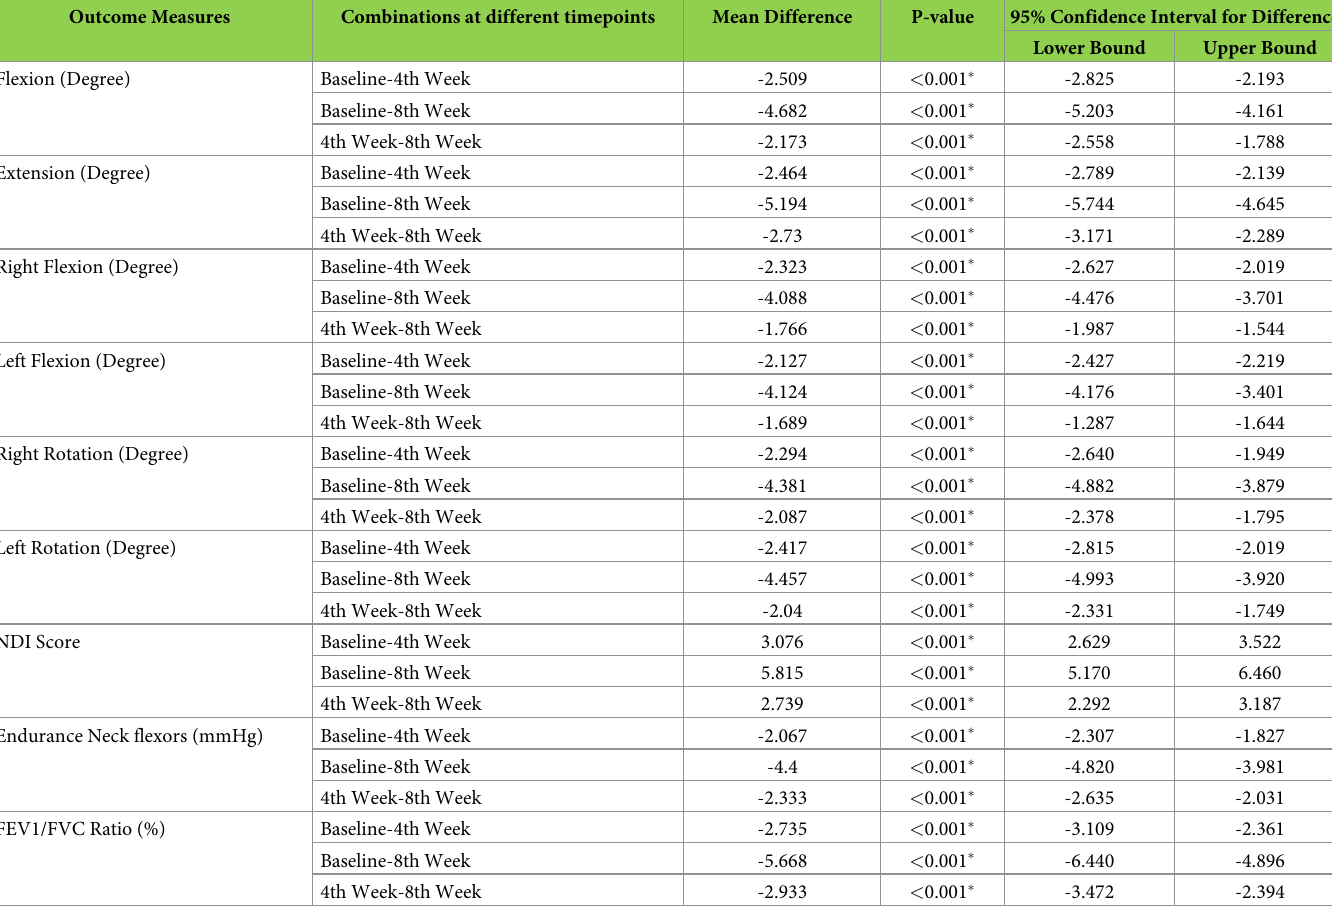
Table 4. Pair wise comparison of CAROM, NDI, endurance of neck flexors and FEV1/FVC ratio at baseline, 4 th week and 8 th week. Outcome Measures